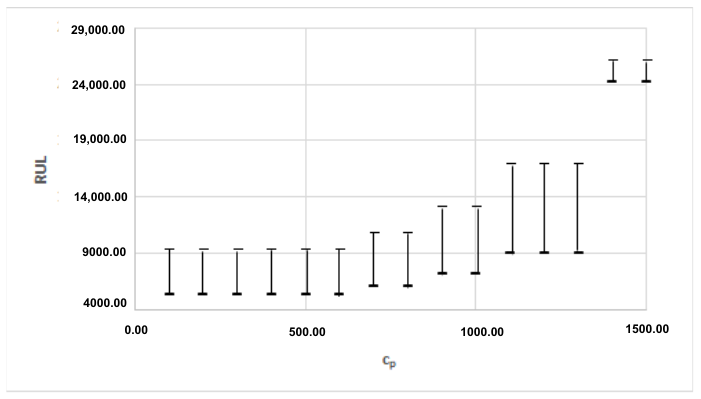
Figure 14. Variations of [ RUL lim